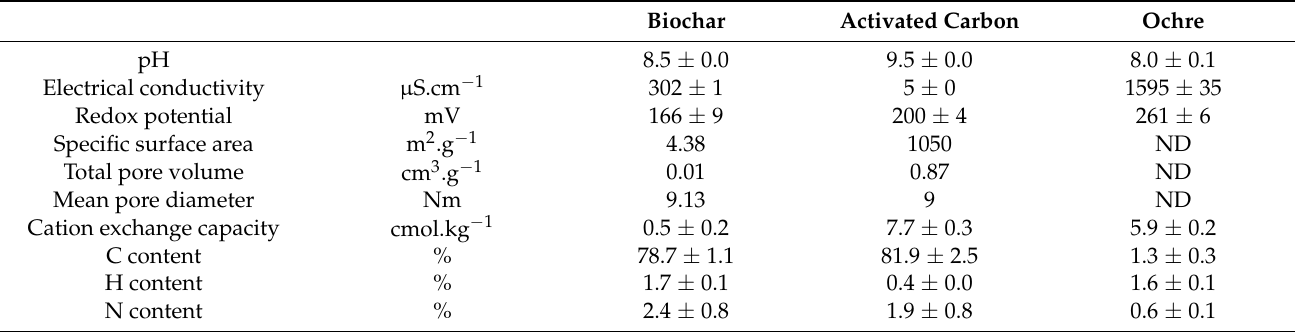
Table 4. Amendments (biochar, activated carbon, ochre) properties. Biochar Activated Carbon